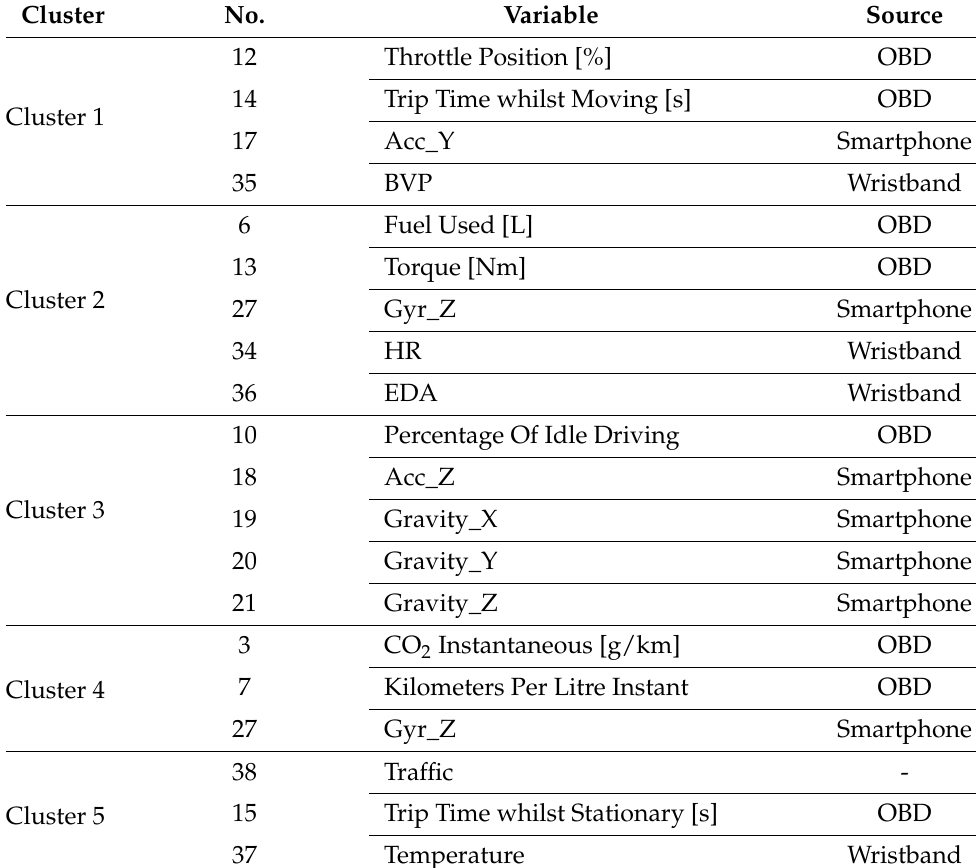
Table 1. PCA results—data features in the first four principal